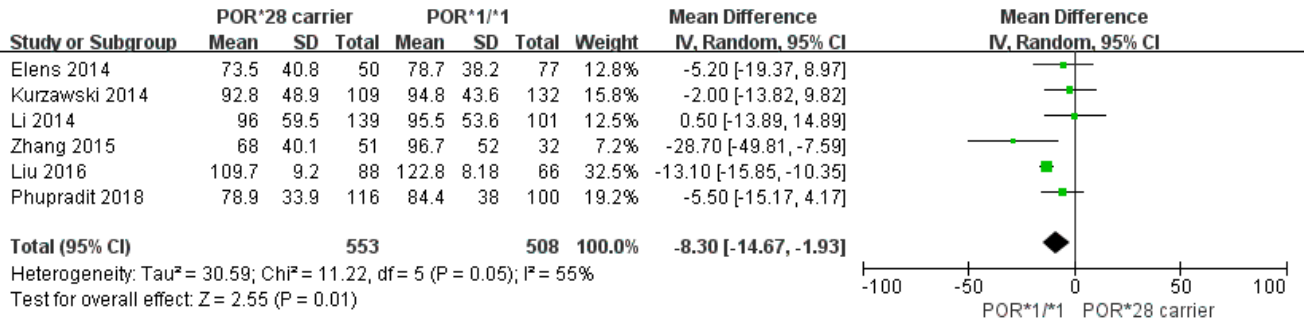
Figure 3. A funnel plot showing the association between POR*28 carriers and standardized trough